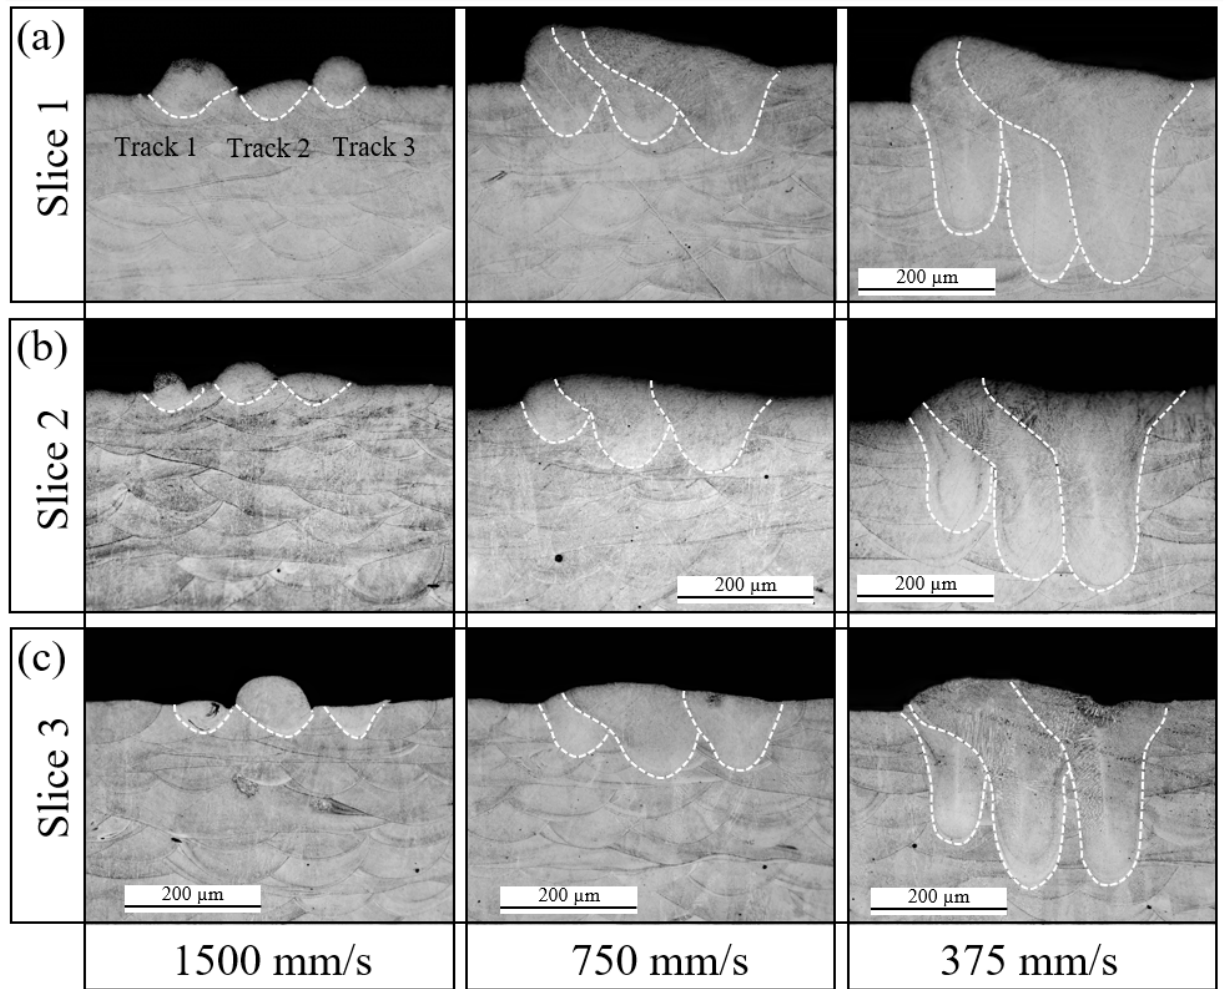
Figure 10. Transverse melt pool boundary of 1.0 mm scan length from ( a ) slice 1, ( b ) slice 2, and ( c ) slice 3 formed with 195 W laser power, 120 µm hatch spacing and scanning speeds of 1500 mm/s (left), 750 mm/s (center), and 375 mm/s (right).